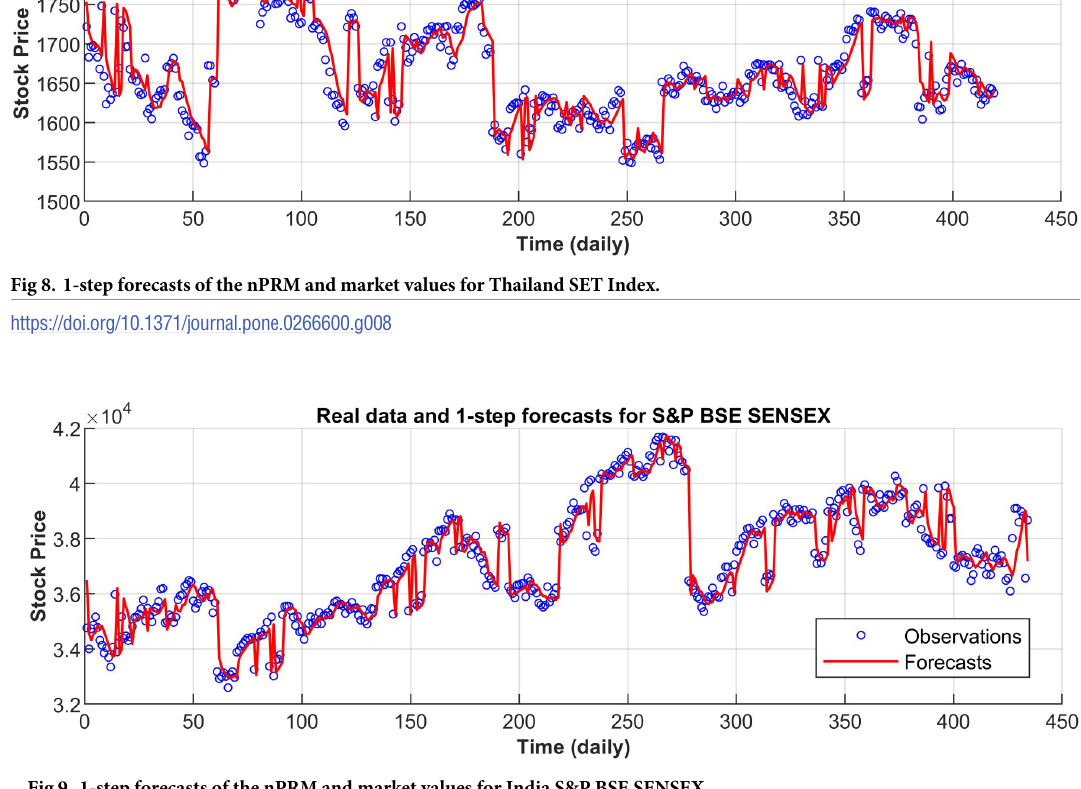
Fig 9. 1-step forecasts of the nPRM and market values for India S&P BSE SENSEX.